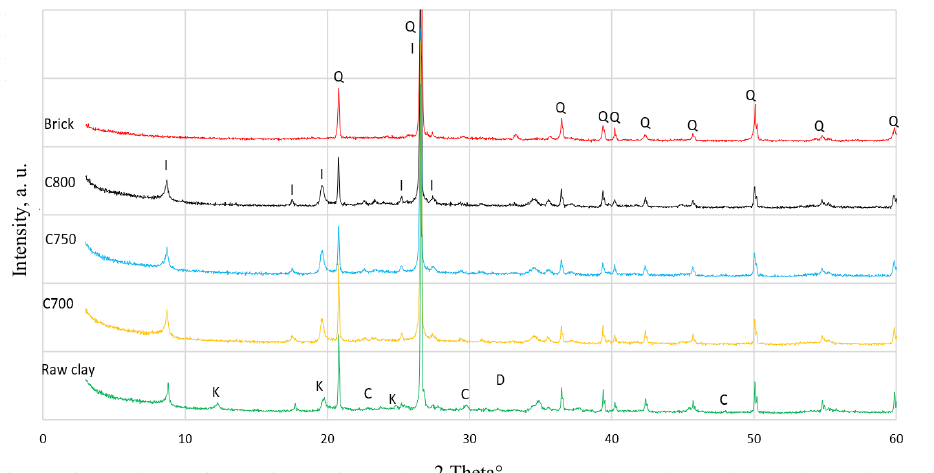
Fig. 2. The X-ray diffraction patterns of red brick waste, raw red clay and calcined red clay at different temperatures. Q – quartz SiO 2 (PDF-2 # 77-1060); I – illite (PDF-2 # 26-911); K – kaolinite (PDF-2 # 83-971); C – calcite CaCO 3 (PDF- 2 #